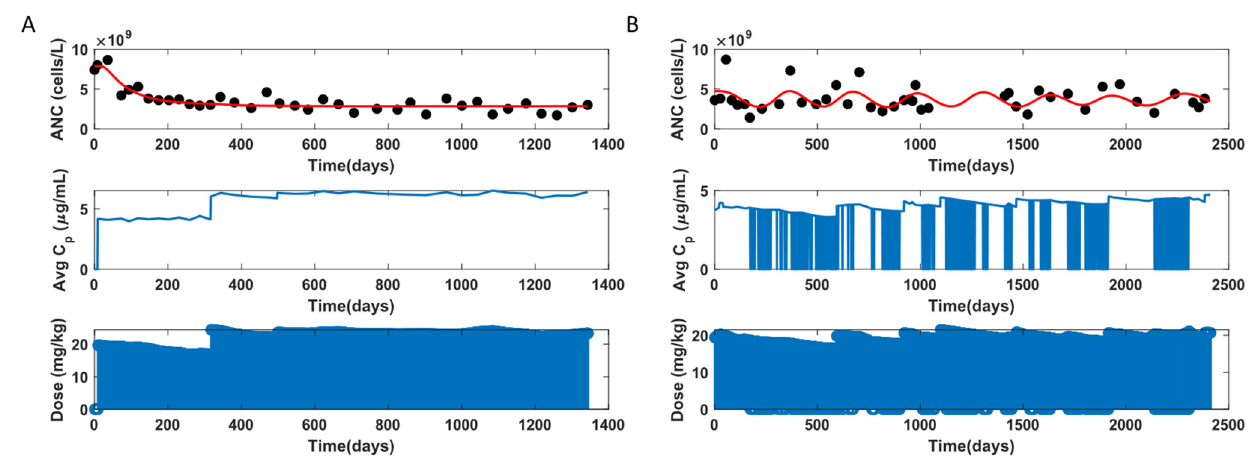
Figure 15. ANC model fit to data for two representative participants. ( A ): Adherent, ( B ): Non- adherent.